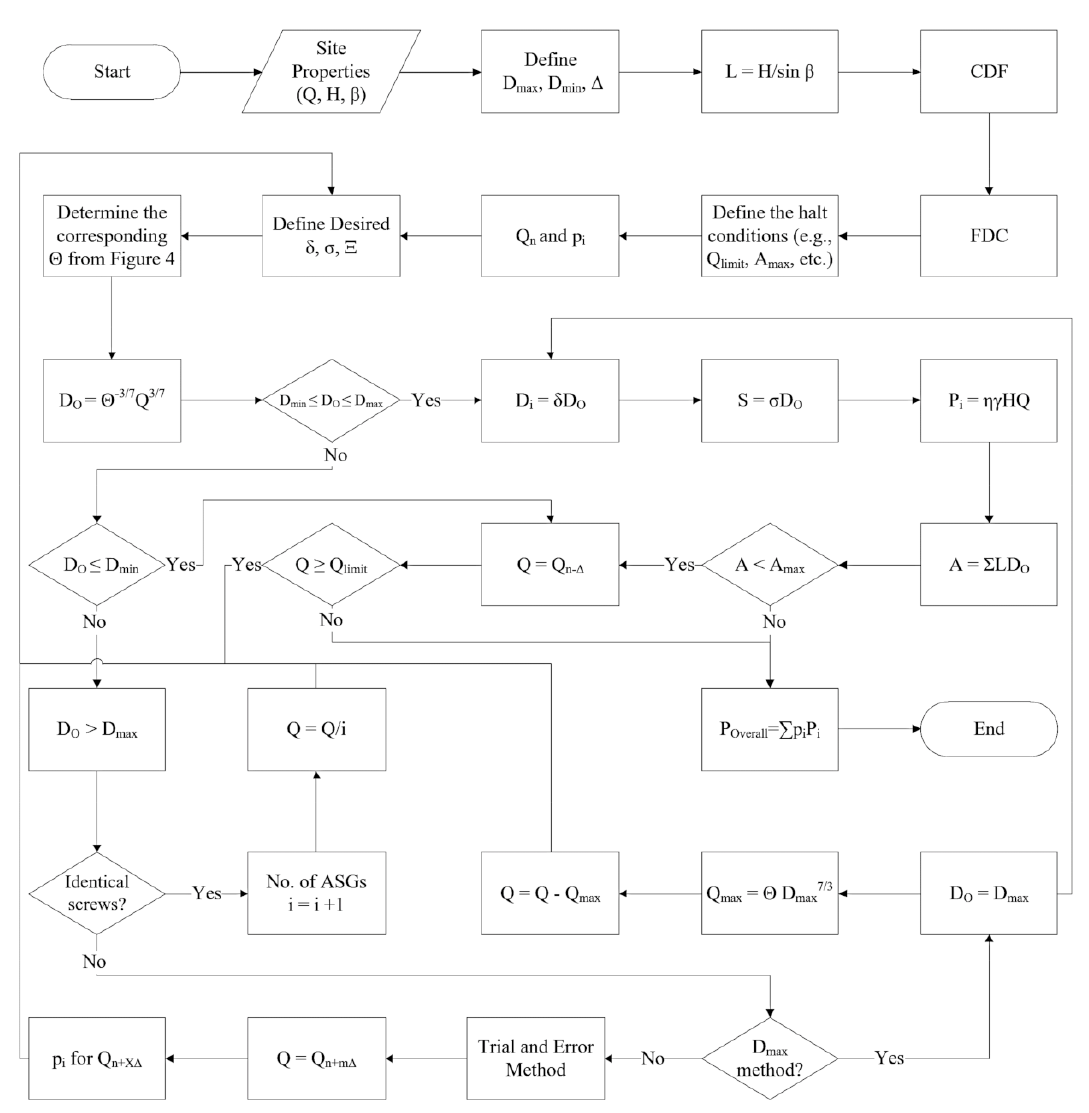
Figure 10. The guideline for quick estimations of Archimedes screw power plants